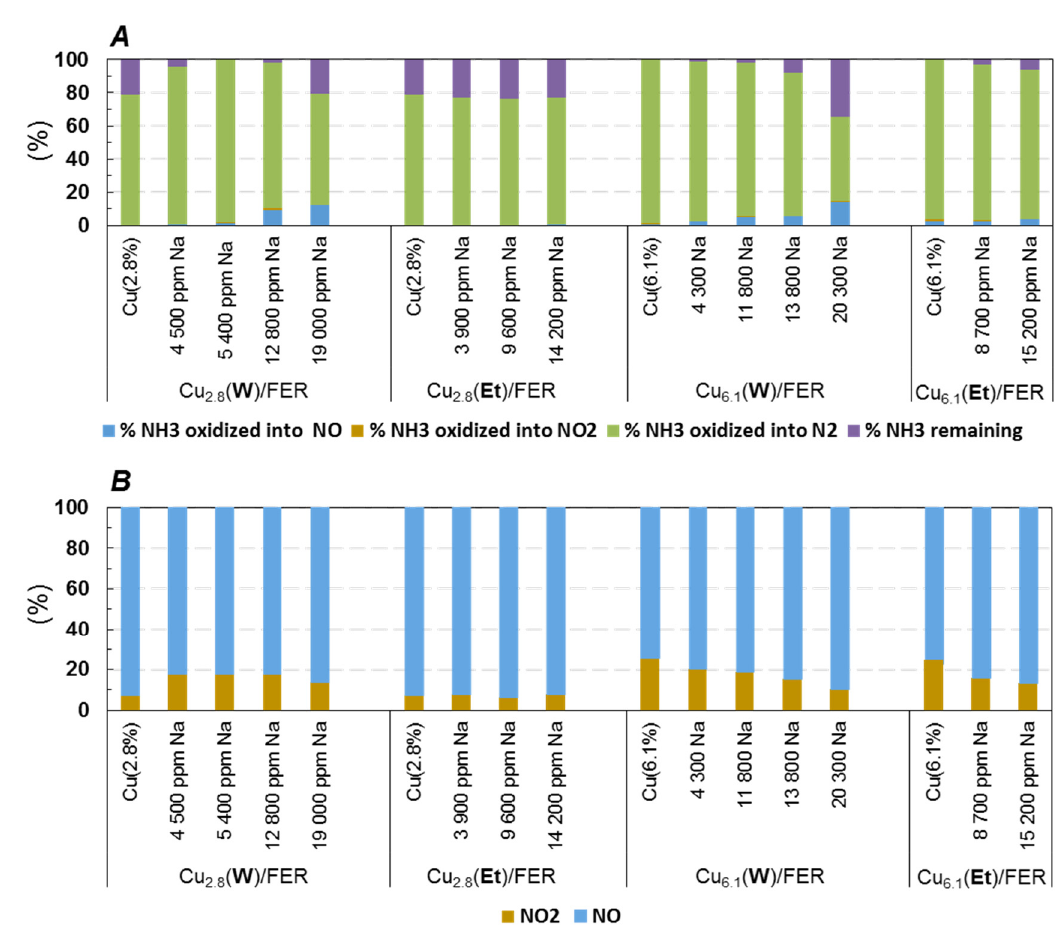
Figure 3. Effect of Na loading on NH 3 ( A ) and NO ( B ) oxidation activities at 450 °C over Cu 2.8 /FER and Cu 6.1 /FER, depending on the Na loading impregnated in water (W) or ethanol (Et).